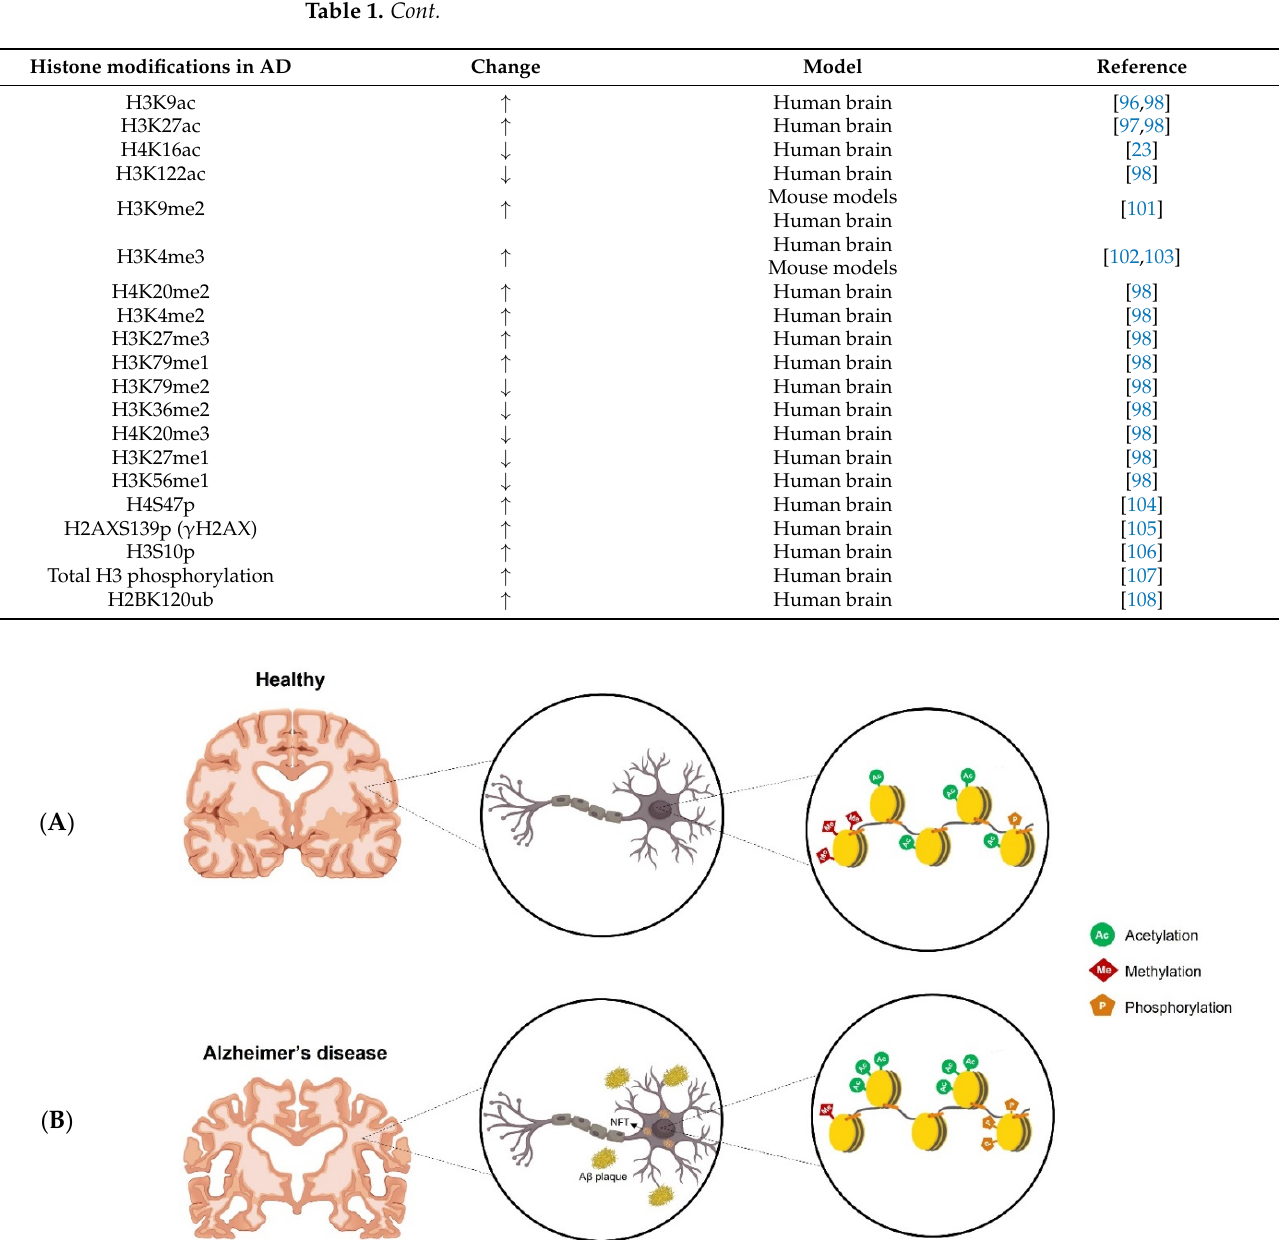
Figure 2 . Dysregulation of epigenetic modifications in AD . In the healthy brain, there are a number of epigenetic modifications thar occur on histone tails, such as acetylation, methylation, and phos- phorylation ( A ). In AD brains, however, gains or losses of histone modifications can be observed ( B ). Table 1. Main histone modification changes associated with aging and AD.